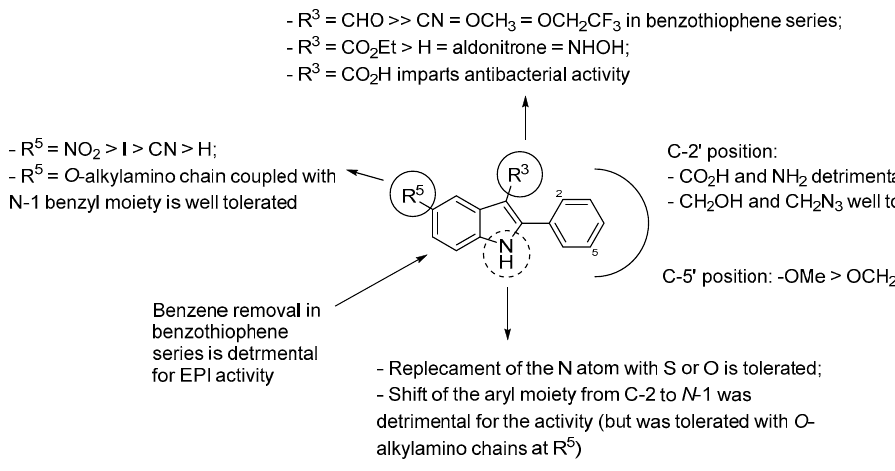
Figure 6. SAR of indole derivatives as NorA